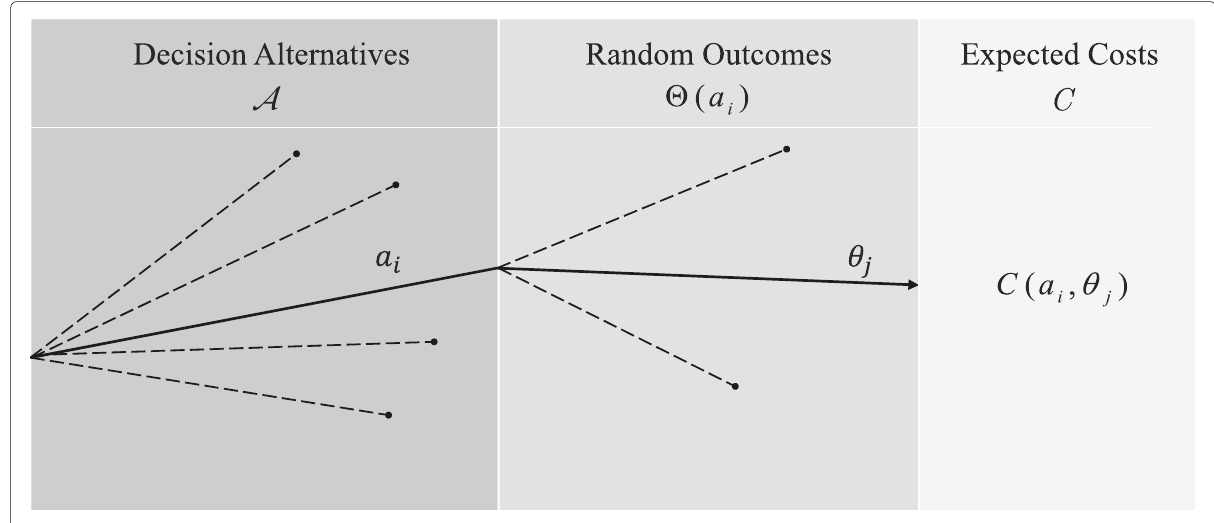
Fig. 3 Decision tree for prior decision